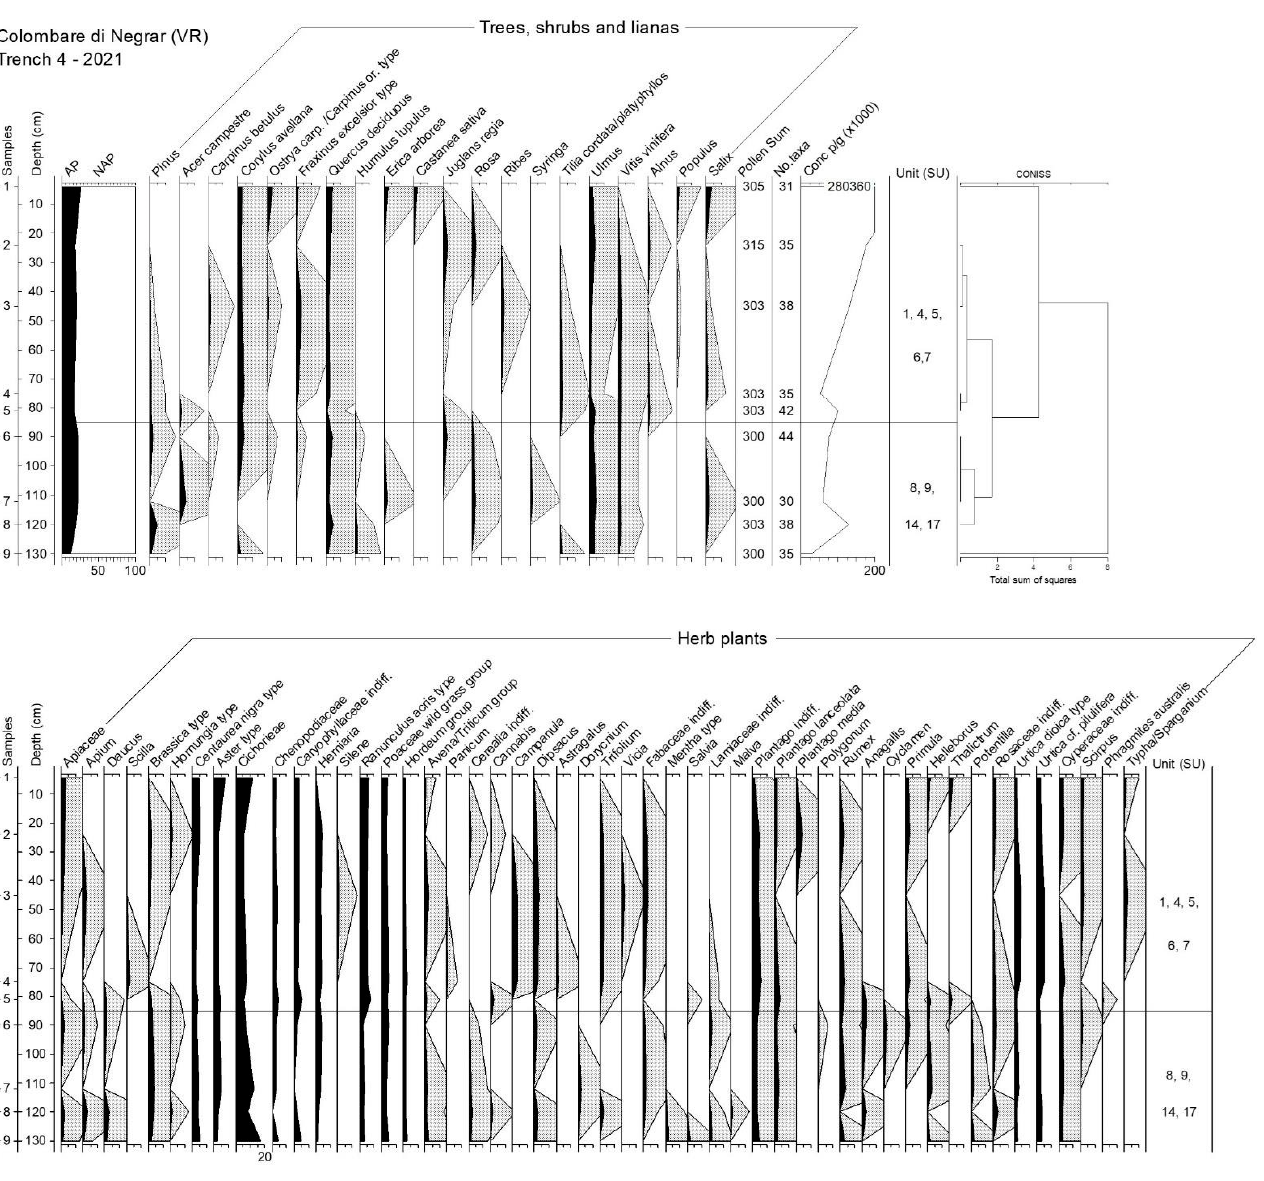
Figure 5. Colombare di Negrar: Percentage pollen diagram of Trench 4—2021; data are arranged in curves following the sequence of samples shown in Figure 2. Dark curves are the true values; grey curves represent the data enhanced × 10.